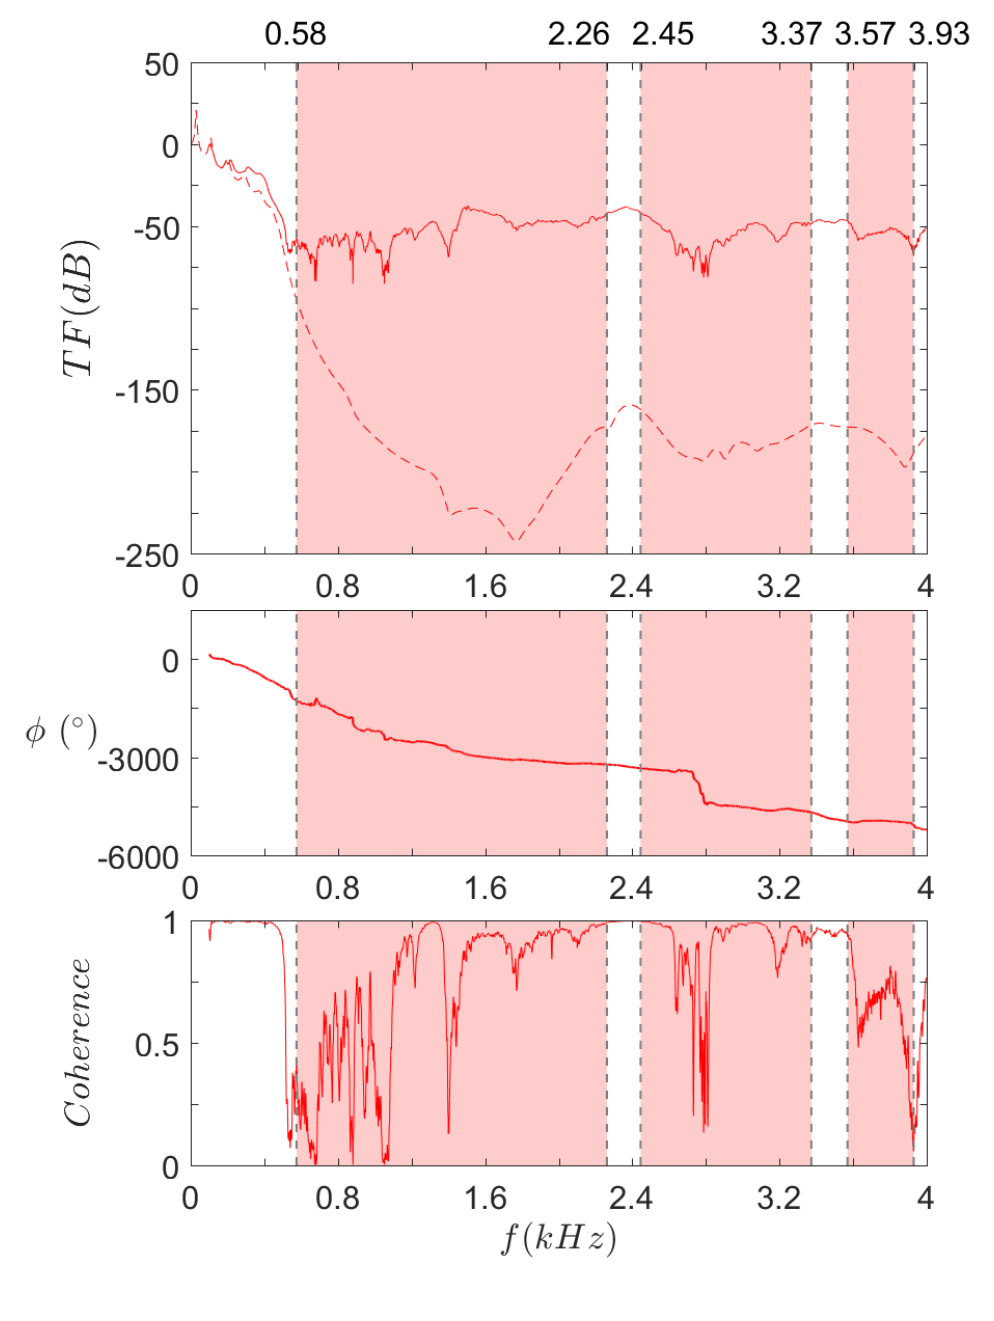
Figure 17. Transfer function ( top ), phase ( middle ), and coherence ( bottom ) of S R . Experimental and computed results. Omnidirectional bandgaps under 4 kHz, as found in the disper- sion